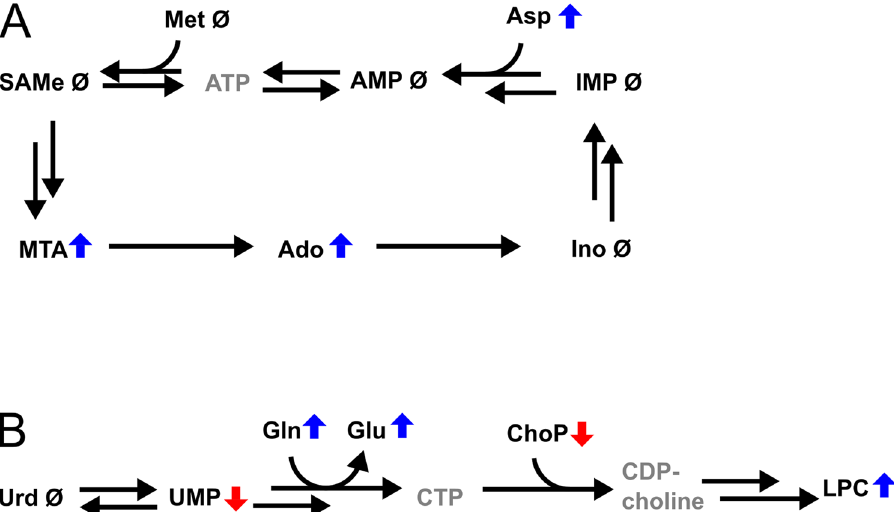
Figure 5. Changes in metabolism of nucleobase-containing compounds in the hippocampus of pallid mice. ( A ) Overview of changes in purine nucleosides and the adenosine salvage pathway via MTA. Ado, adenosine; Ino, inosine; AMP, adenosine monophosphate; ATP, adenosine triphosphate; Met, methionine; SAMe, S-adenosyl- L-methionine; MTA, methylthioadenosine; Ado, adenosine; Ino, inosine; IMP, inosine monophosphate. ( B ) Overview of changes in the pyrimidine nucleoside/nucleotide pathway and lysophospholipid synthesis. Urd, uridine; UMP, uridine monophosphate; CTP, cytidine triphosphate; CDP-choline, cytidine diphosphate choline; ChoP, phosphocholine; LPC, lysophosphatidylcholine; Gln, glutamine; Glu, glutamate. Blue arrows, upregulation in hippocampus of pallid mice; red arrow, downregulation; Ø, no change. Greyed-out metabolites were not observed or